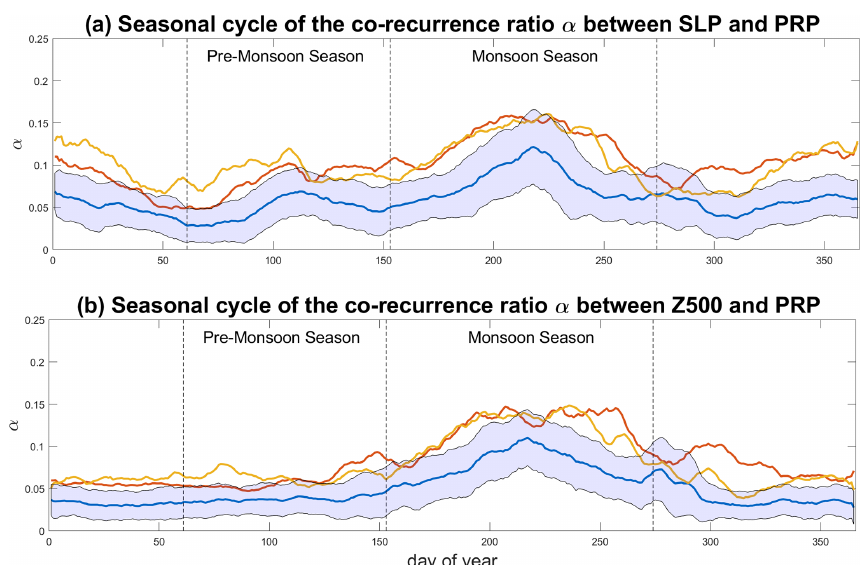
Figure A4. The same as Fig. 5 but using the domain 10–30 ◦ N, 15 ◦ W–20 ◦ E.